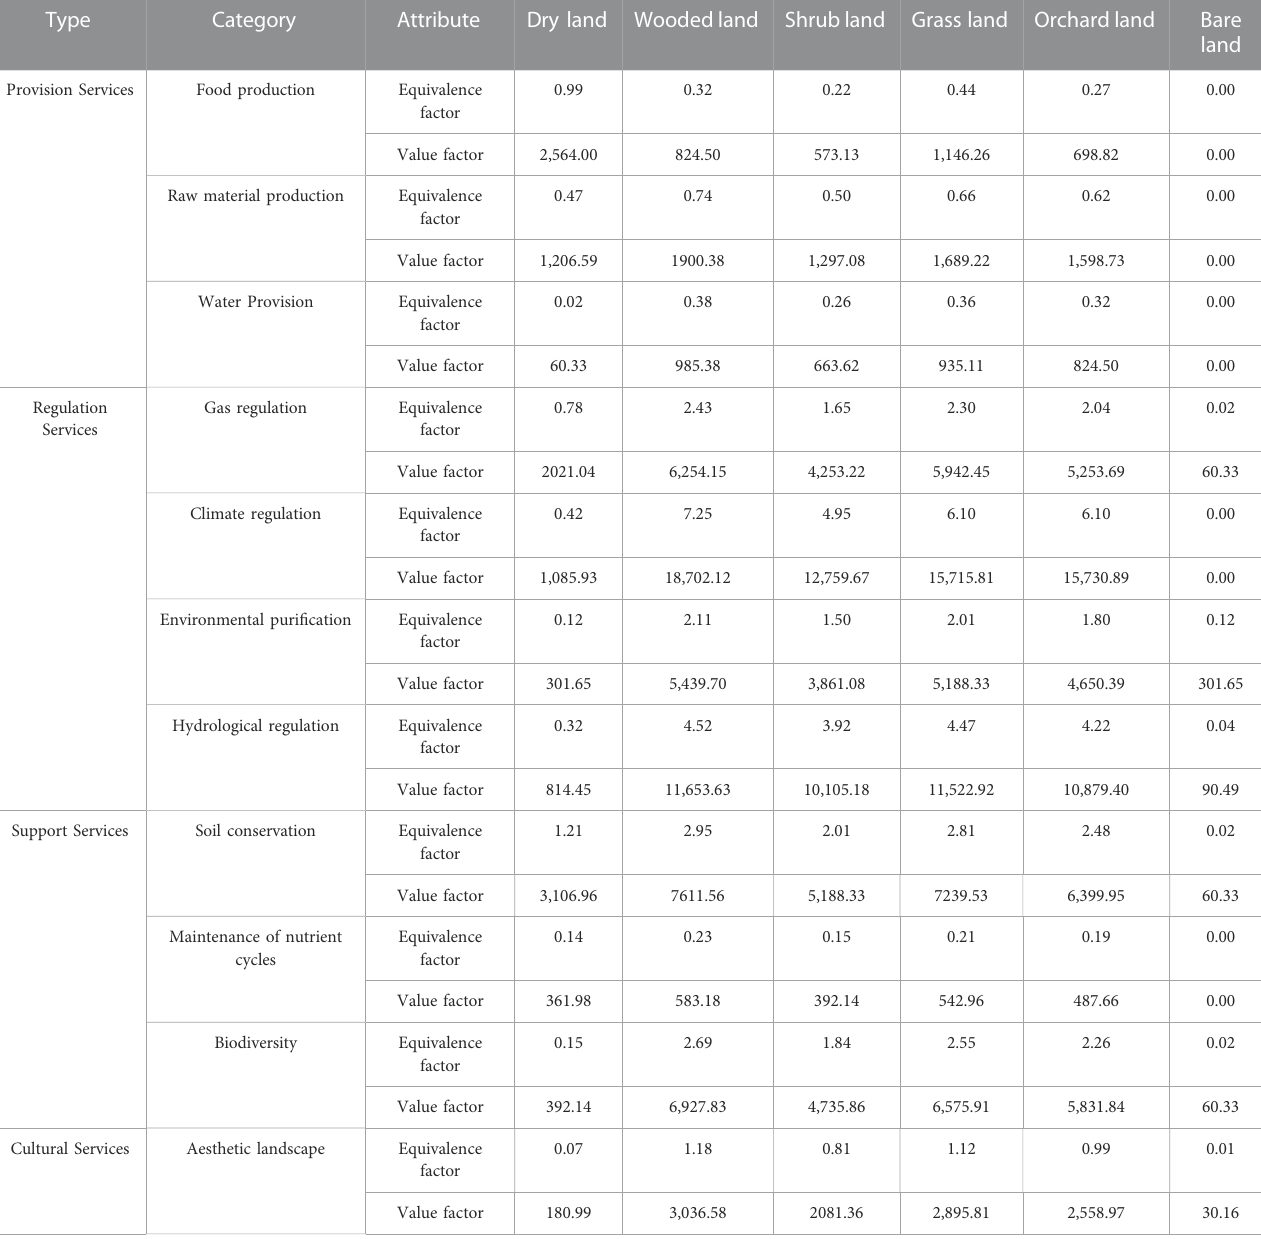
TABLE 2 Value of ecosystem services coef fi cients for different land uses in the study